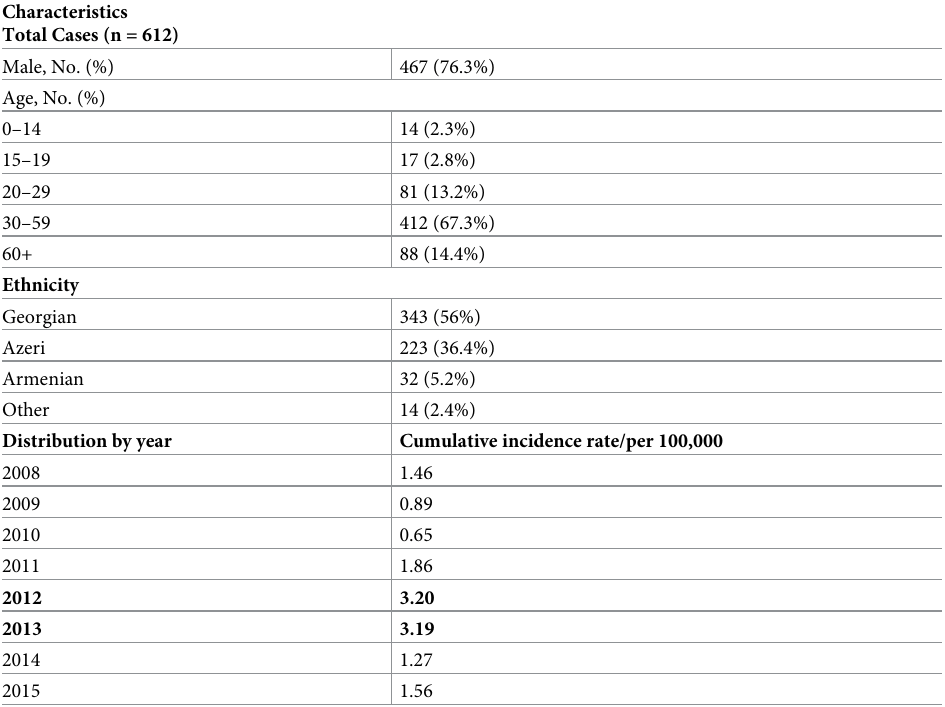
Table 2. Epidemiological characteristics of human cutaneous anthrax cases in the country of Georgia,